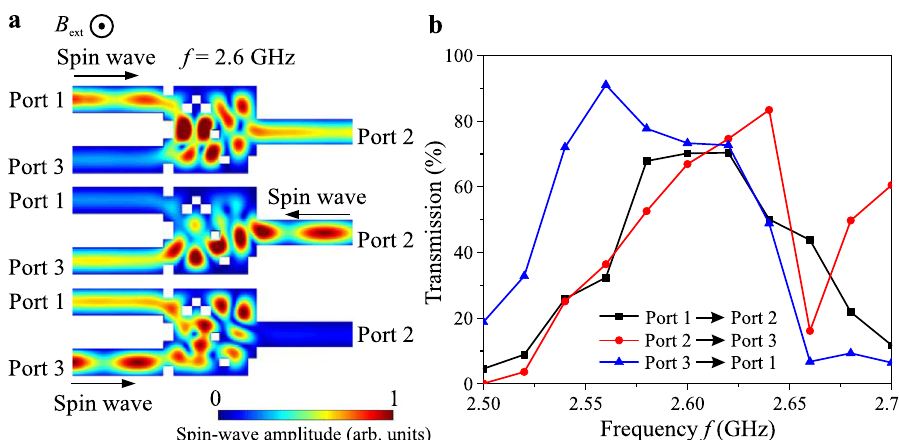
Fig. 5 Nonreciprocal magnonic circulator. a The normalized spin-wave amplitude distribution for different inputs at the same frequency of 2.6 GHz. Spin waves are excited at the three different ports and are guided to one of the other ports according to the rule: 1 → 2 → 3 → 1. b The transmissions of spin waves between different inputs (open direction) as a function of the frequency simulated for the same optimized device. A broad 3 dB bandwidth of around 100 MHz and a transmission for all the three cases close to 70% is observed (the crosstalk is smaller than 12%). The number of iterations is fi ve.